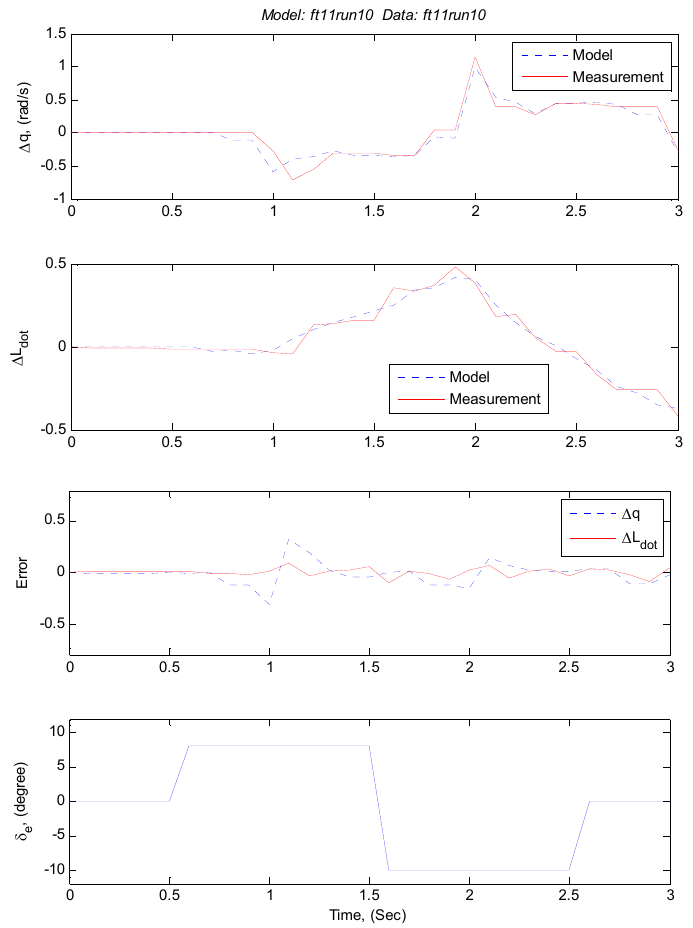
Figure 5, the VAF value of ∆(cid:1869) and (cid:1838) (cid:2929) (cid:4662) are 92.31% and 94.52%, respectively, in which both values satisfy the minimum requirement of VAF at 85% based on the our experience.